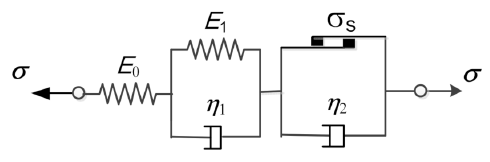
Figure 1. Nishihara